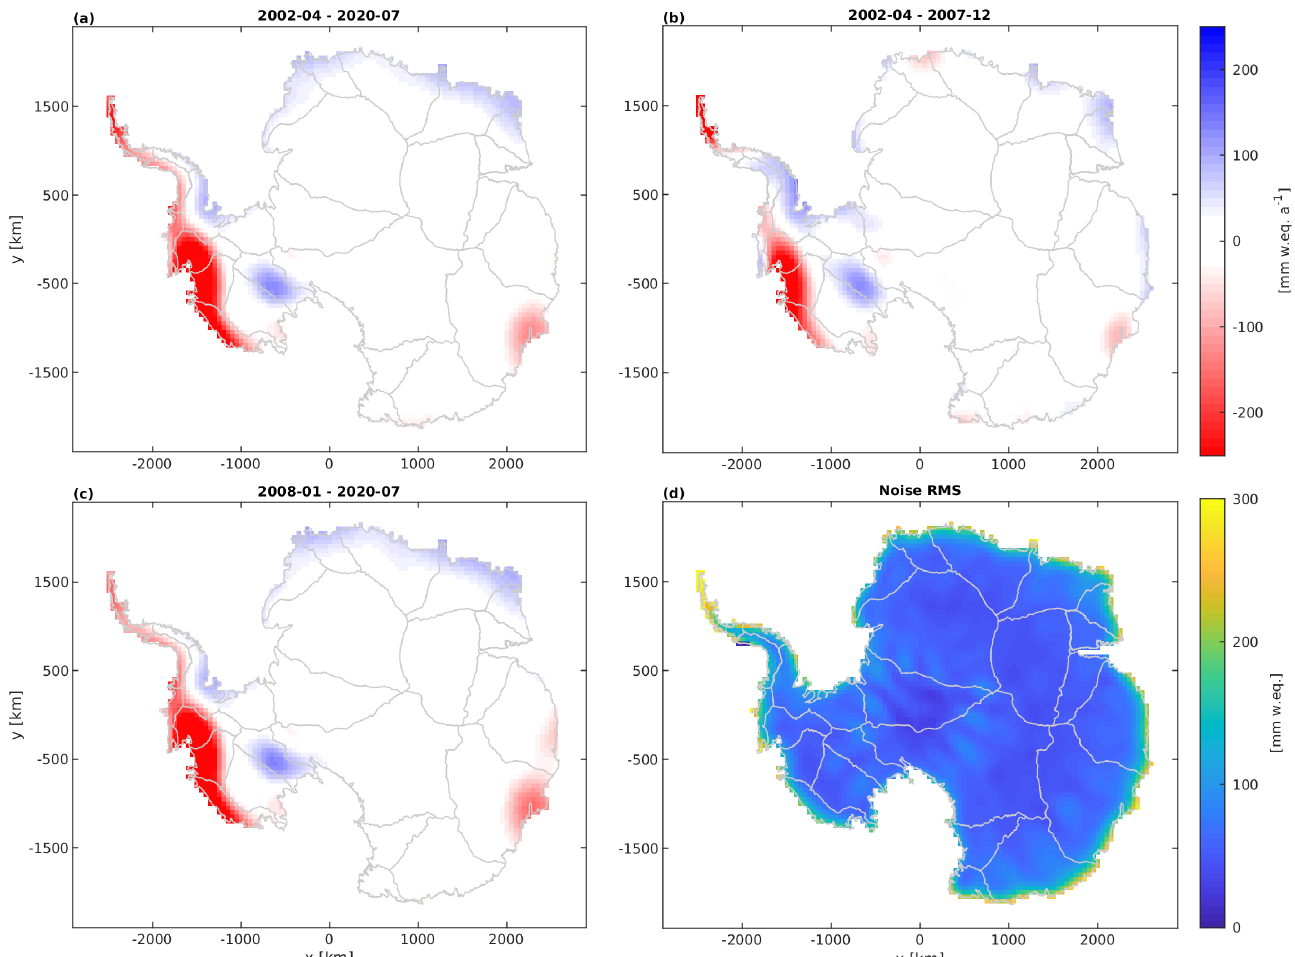
Figure 8. ( a – c ) Linear trends over different periods derived from the gridded mass change product using the standard model. ( d ) Noise level of each grid cell, assessed as described in Section 2.5.2. All results are based on variant (ICE,FAR,ANTOC,1.0) of the gridded